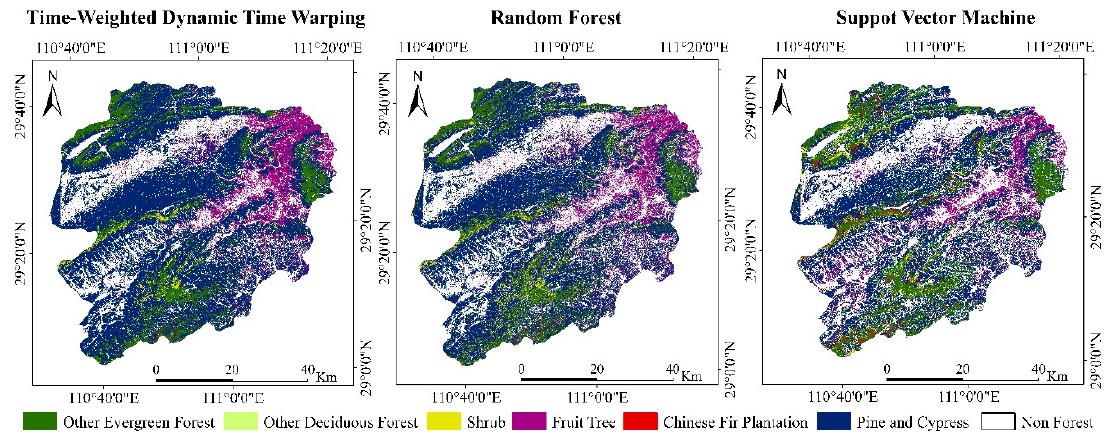
Figure 9. Classification maps obtained using TWDTW, RF, and SVM in another test area.